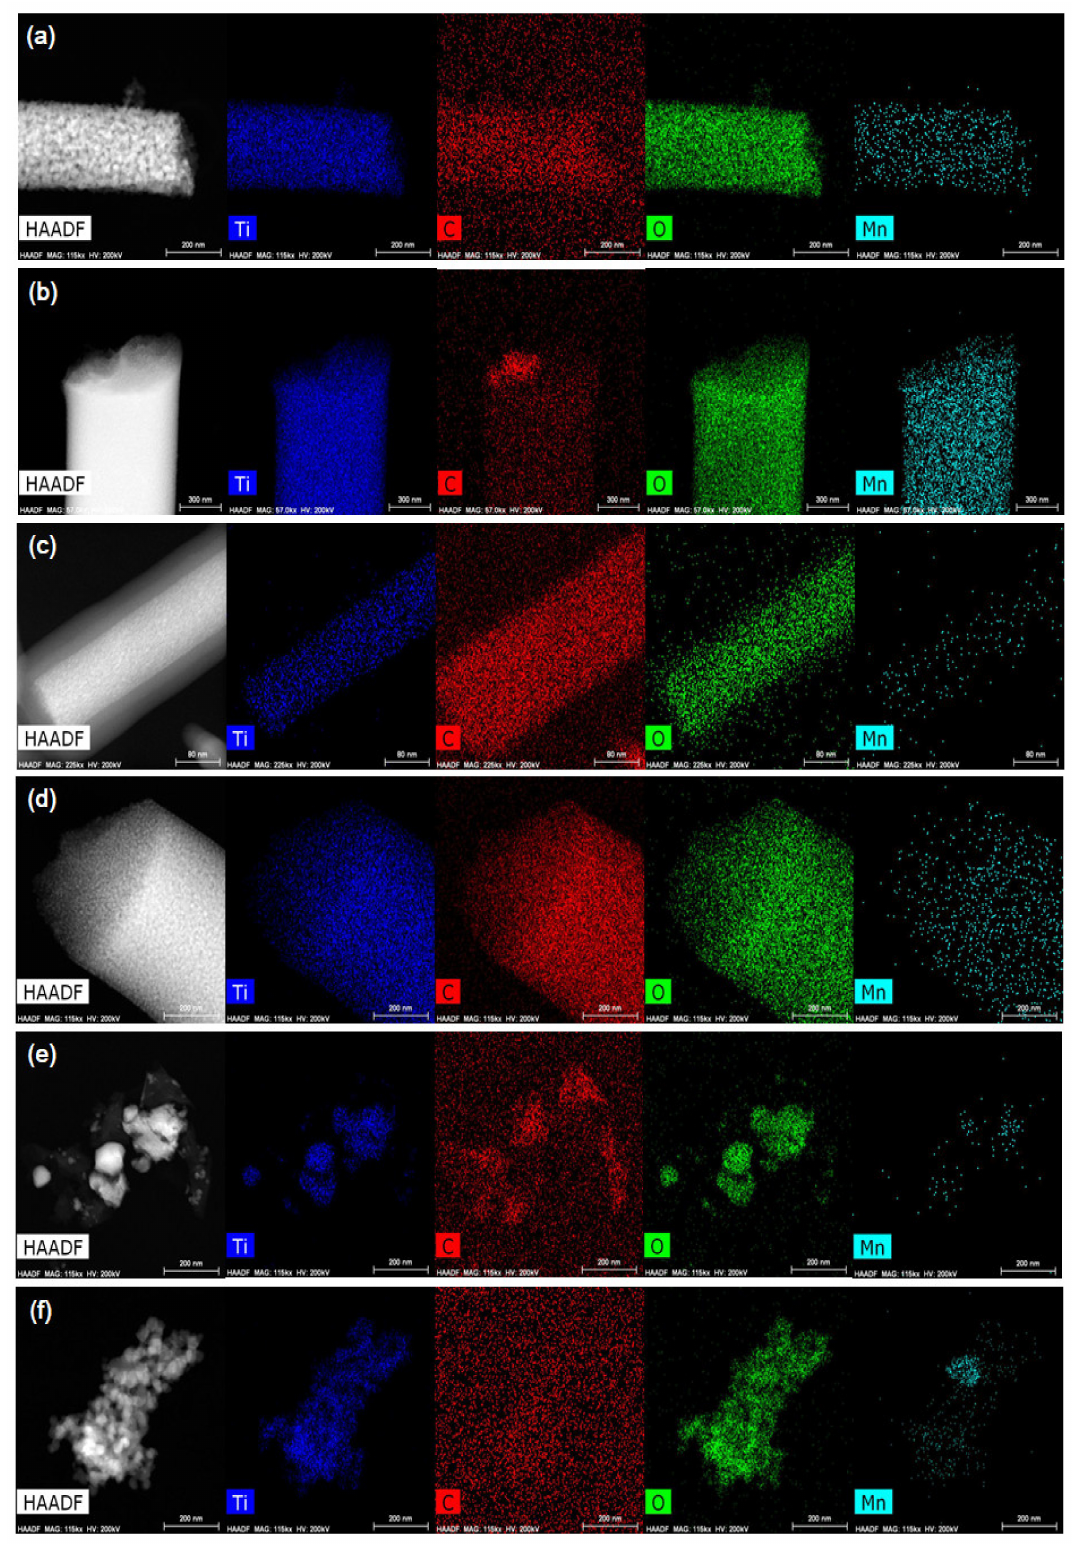
Figure4. ElementalmappingforTi, C,O,andMnasdeducedfromHR-TEMimagesof( a )T(G–Mn1)(550) NW, ( b ) T(G–Mn2)(550) NW, ( c ) T(G–Mn3)(550) NW, ( d ) T(G–Mn1)(800) NW, ( e ) (a) T(G–Mn2)(800) NW, and ( f ) T(G–Mn1)(800)